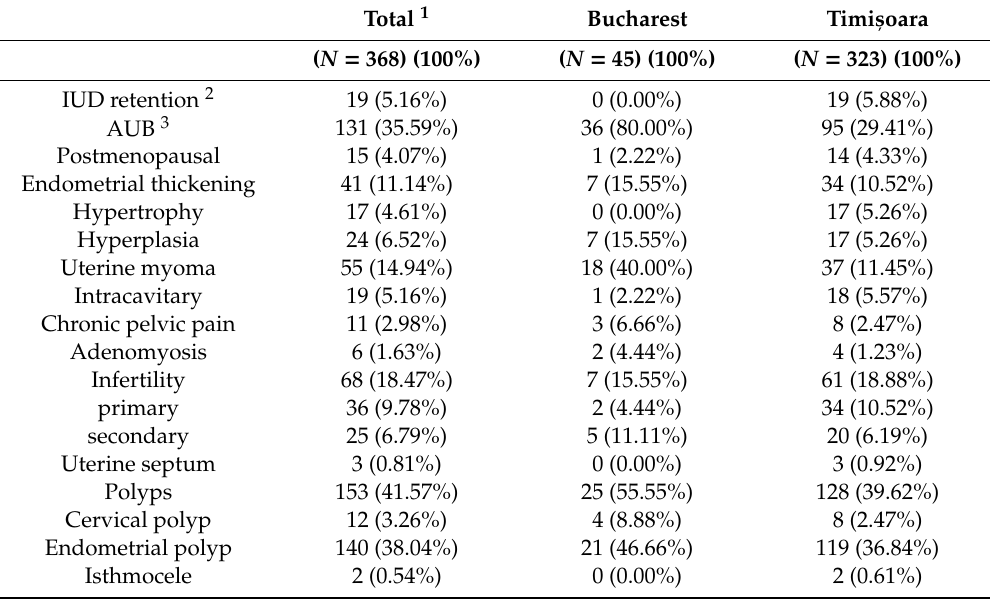
Table 2. Indications for